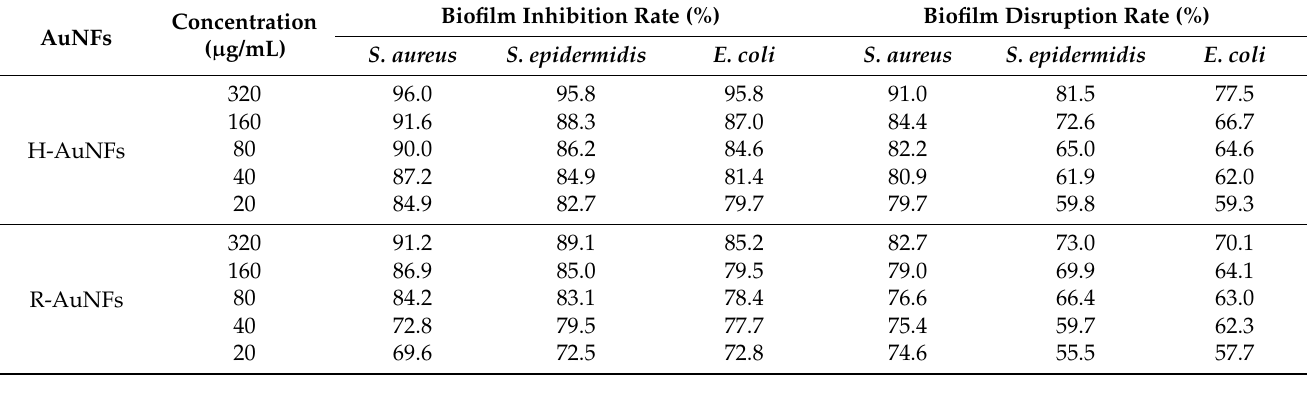
Table 2. The biofilm inhibition and disruption rate of AuNFs against tested bacterial strains at various concentrations.